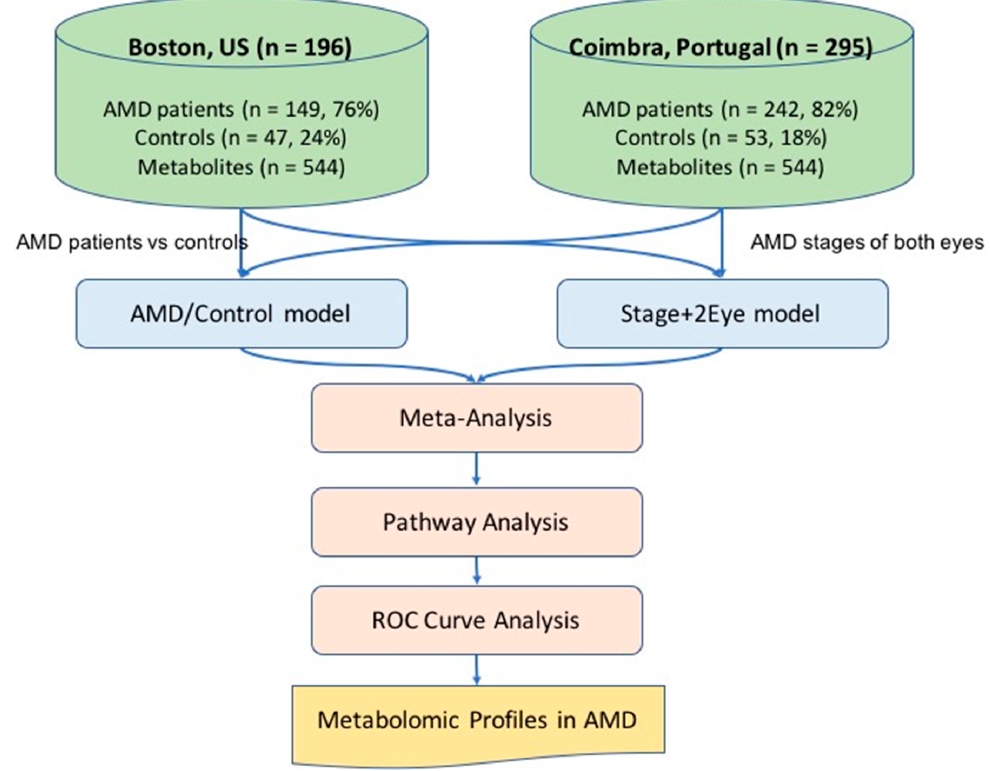
Figure 1. Overview of the study. AMD: age-related macular degeneration; AMD/Control model multivariable logistic regression model considering AMD versus controls as the outcome; Stage+2 Eye: permutation-based cumulative logistic regression model considering both eyes of each patient and the severity stage of disease as the outcome (control, early, intermediate and late); ROC: receiving operating characteristic; n : number. Table 1. Clinical and demographic characterization of the two study cohorts.